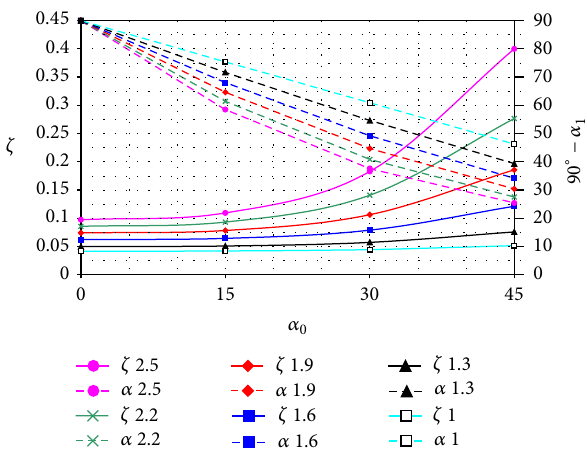
Figure 13: Graphs of 𝛼 1 and 𝜁 depending on the inlet swirl angles 𝛼 0 at different 𝑅 𝑟